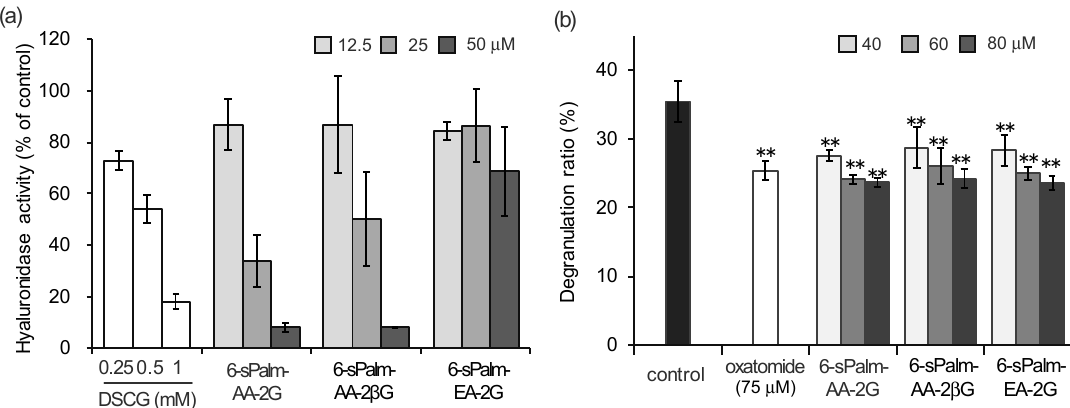
Figure 5. Inhibitory effects of 6-sPalm-AA-2G and its isomers on hyaluronidase activity ( a ) and antigen-induced degranulation ( b ). All data represent means ± SD of three independent experiments. ** p < 0.01 (Dunnett’s test) as compared with the control.